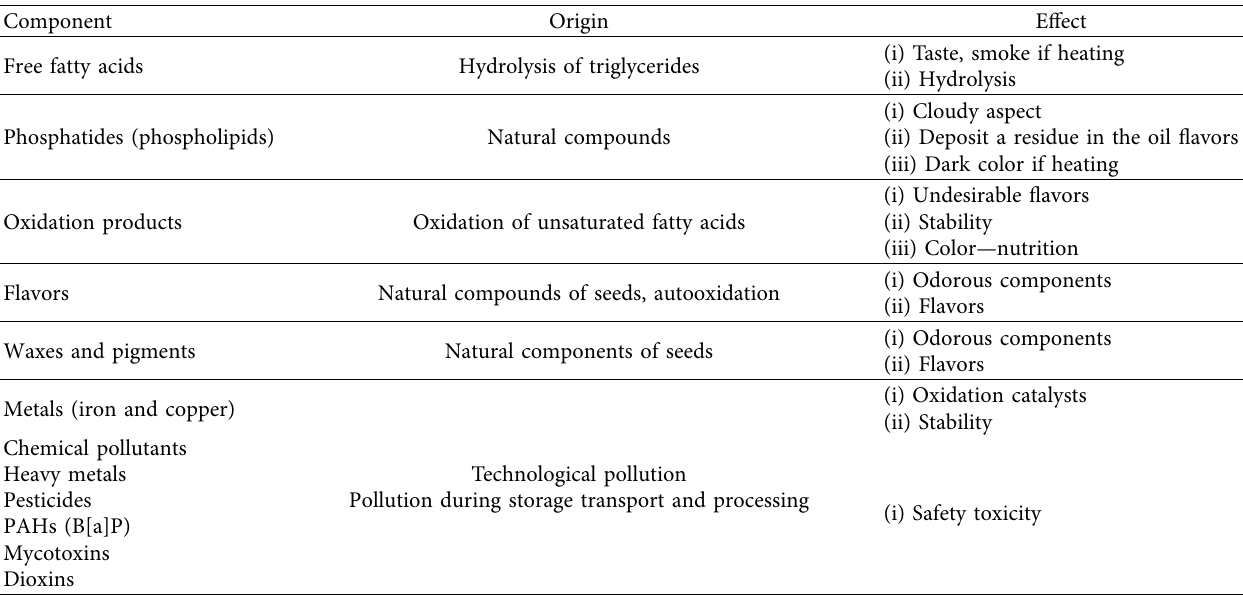
Figure 1: General overview of chemical composition and contaminants of vegetable oils. Table 1: Undesirable constituents in oil removed during